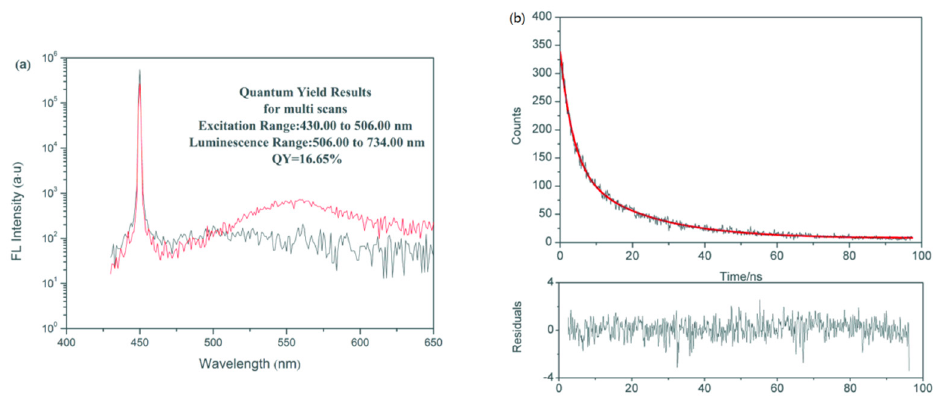
Figure 2. Fluorescence characteristics of CdSe QDs: ( a ) Fluorescence quantum yield of CdSe QDs. In the figure, the black spectrum represent the quantum yield (QY) results for barium sulfate solution, the red spectrum represent the QY results of CdSe QDs (in ethanol). ( b ) Fluorescence lifetime of CdSe QDs. Where the red line represent the fluorescence lifetime fitting curve of CdSe QDs, R 2 = 0.99.